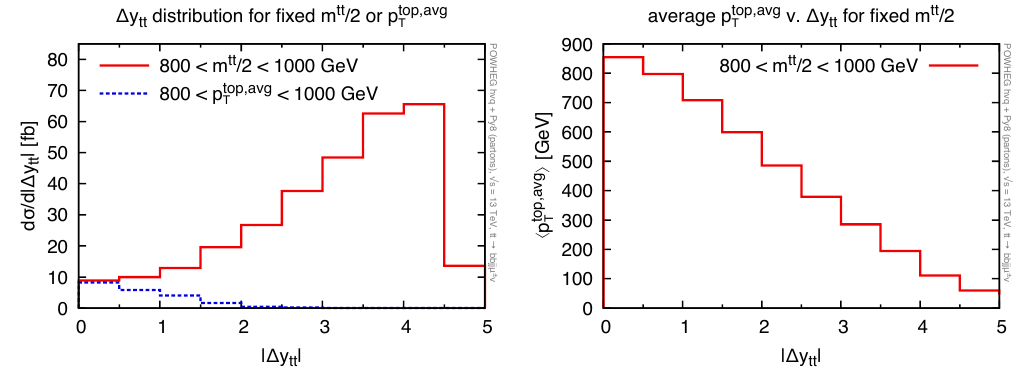
Figure 5 . Left: the distribution of | ∆ y | in for events where the t ¯ t pair is in a given bin of either t ¯ t . Right: the average of the two top transverse momenta versus | ∆ y m t ¯ t / 2 or p top,avg T bin of m t ¯ t / 2 . We include all topologies in these results, keeping in mind that FCR is always the dominant contribution